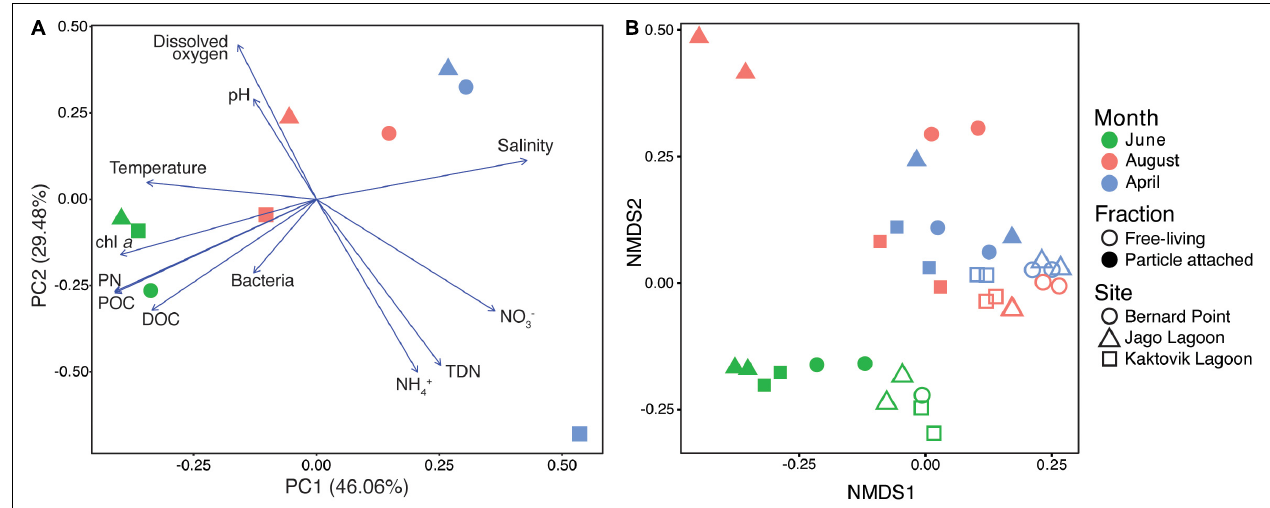
FIGURE 2 | (A) Principal component analysis plot of environmental measurements, and (B) non-metric multidimensional scaling plot of gene per million (GPM) data for KEGG-annotated protein coding genes. Stress of NMDS is 0.085.